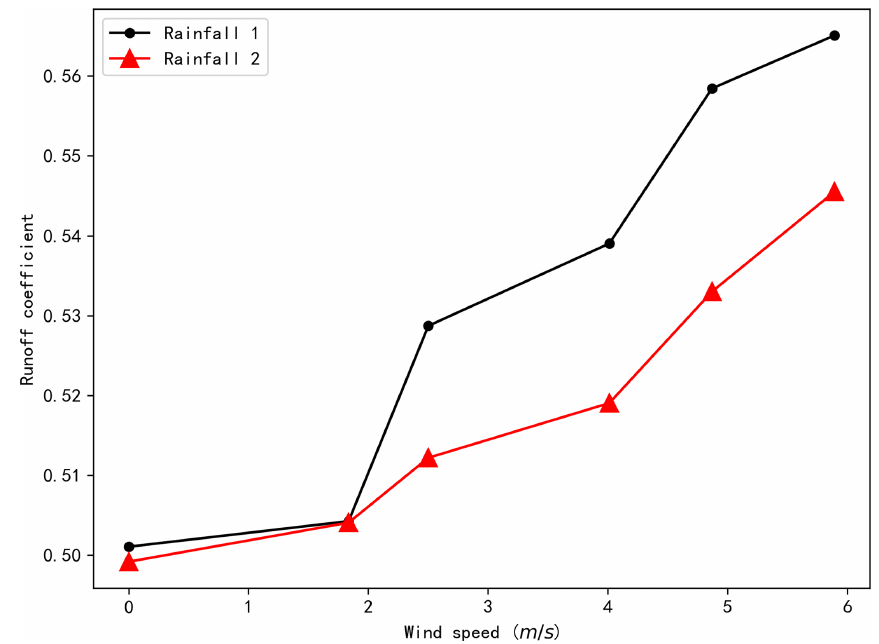
Figure 7. The runoff coefficients of the scale model for different wind speeds under the two types of rainfall.